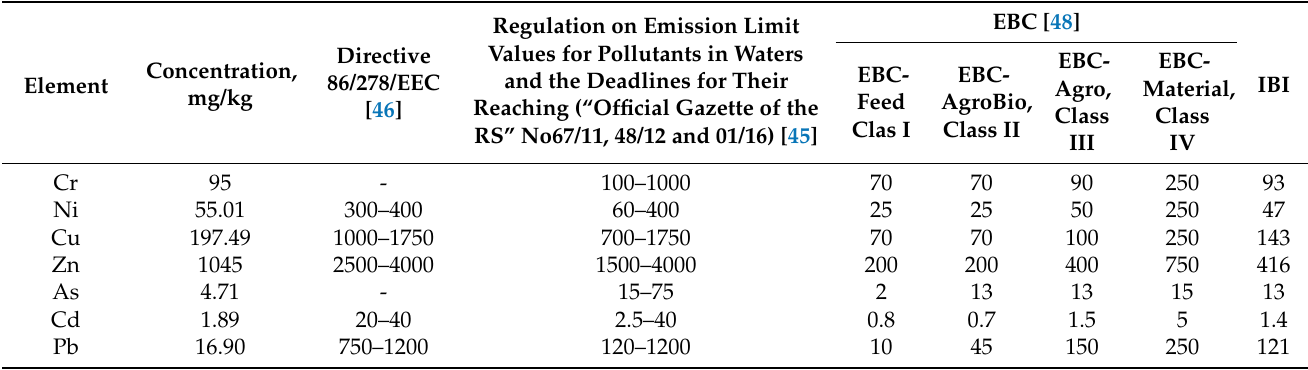
Table 7. Nutrient release efficiency after 1 and 5 leaching cycles from FS treated. Table 6. Chemical analysis of the FS treated material.